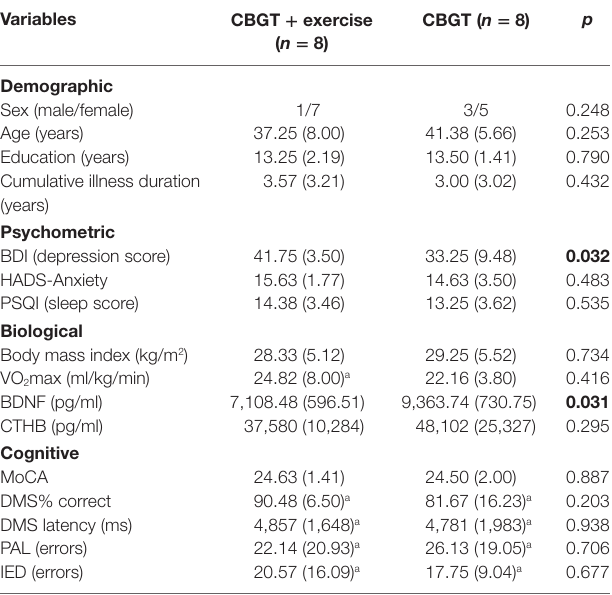
TaBle 2 | Baseline characteristics of depressed